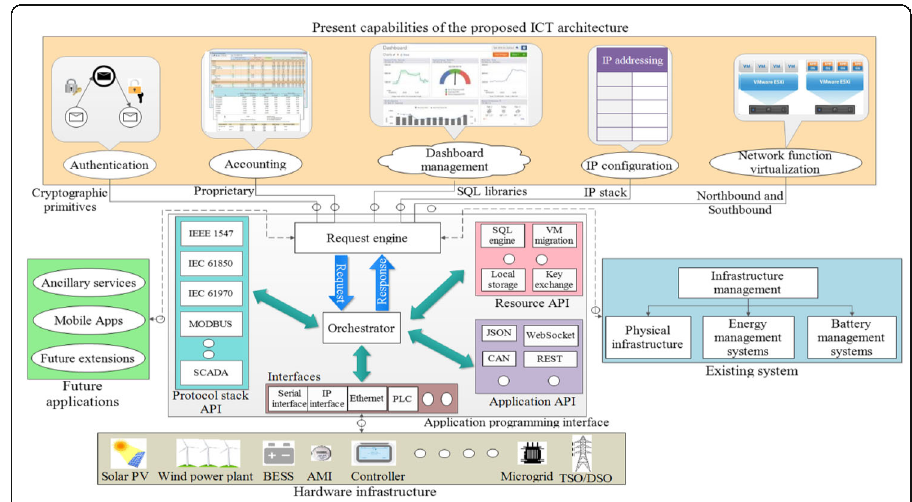
Fig. 1 ICT architecture for future distribution